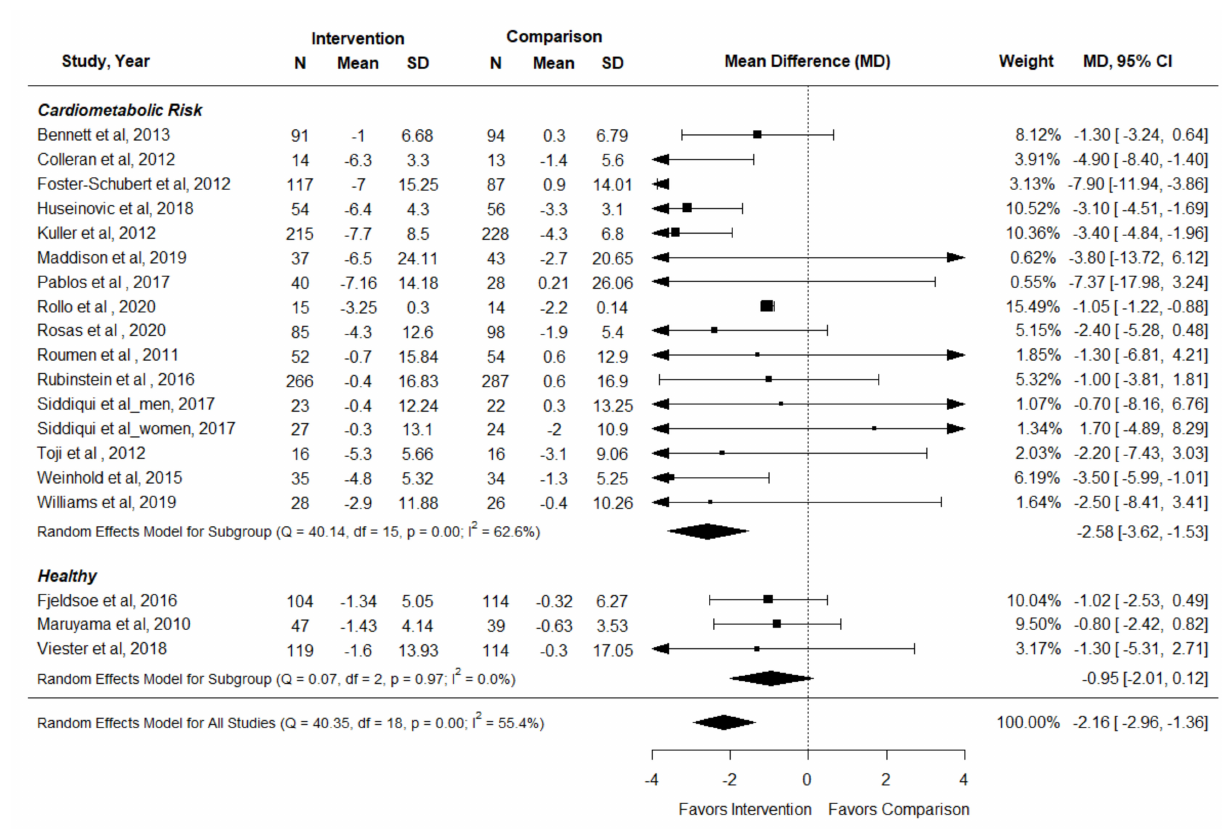
Figure 5. Forest plot for waist circumference in the systematic review examining effect of nutrition and physical activity interventions provided by nutrition and exercise practitioners for the general population